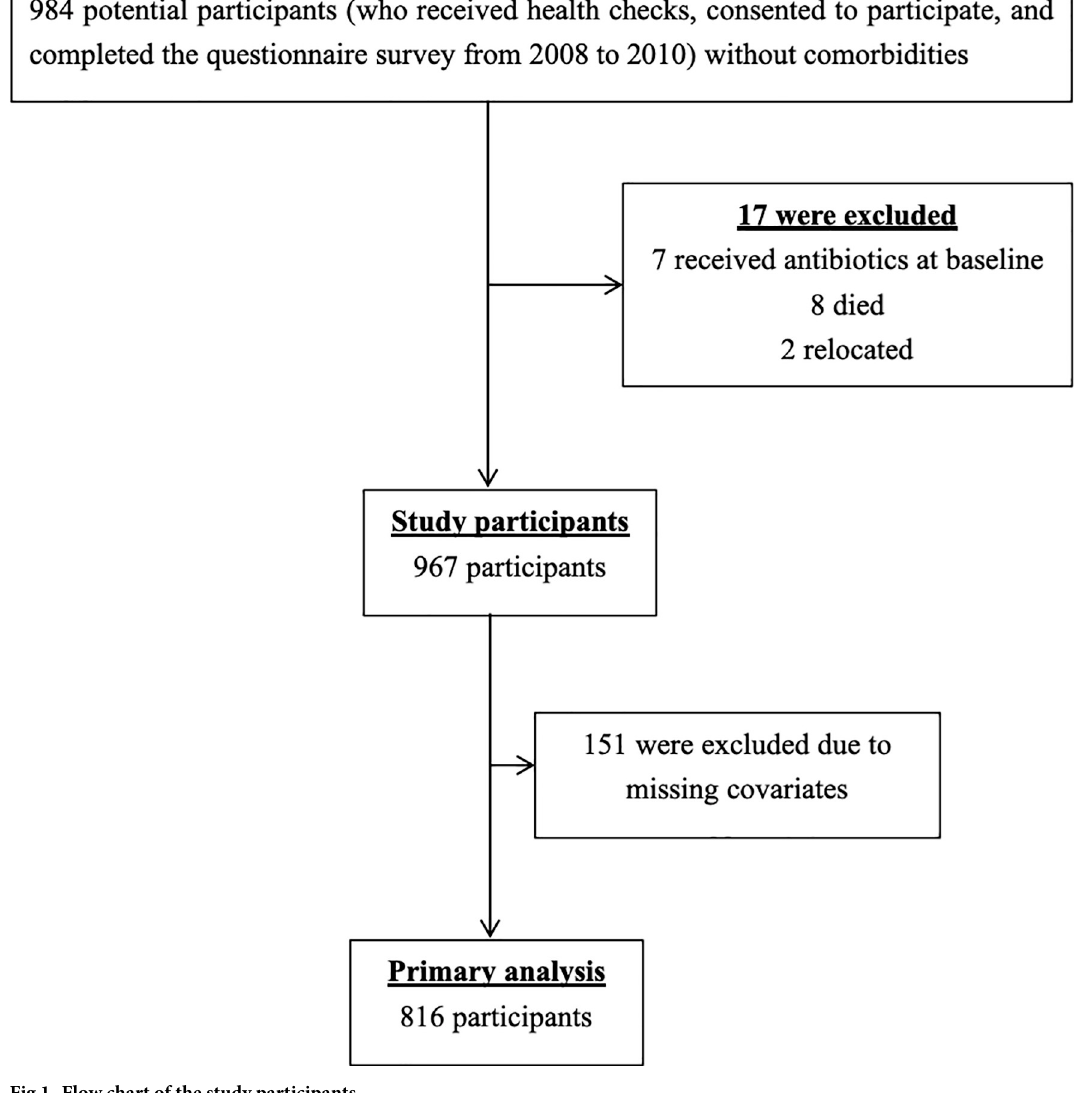
Fig 1. Flow chart of the study